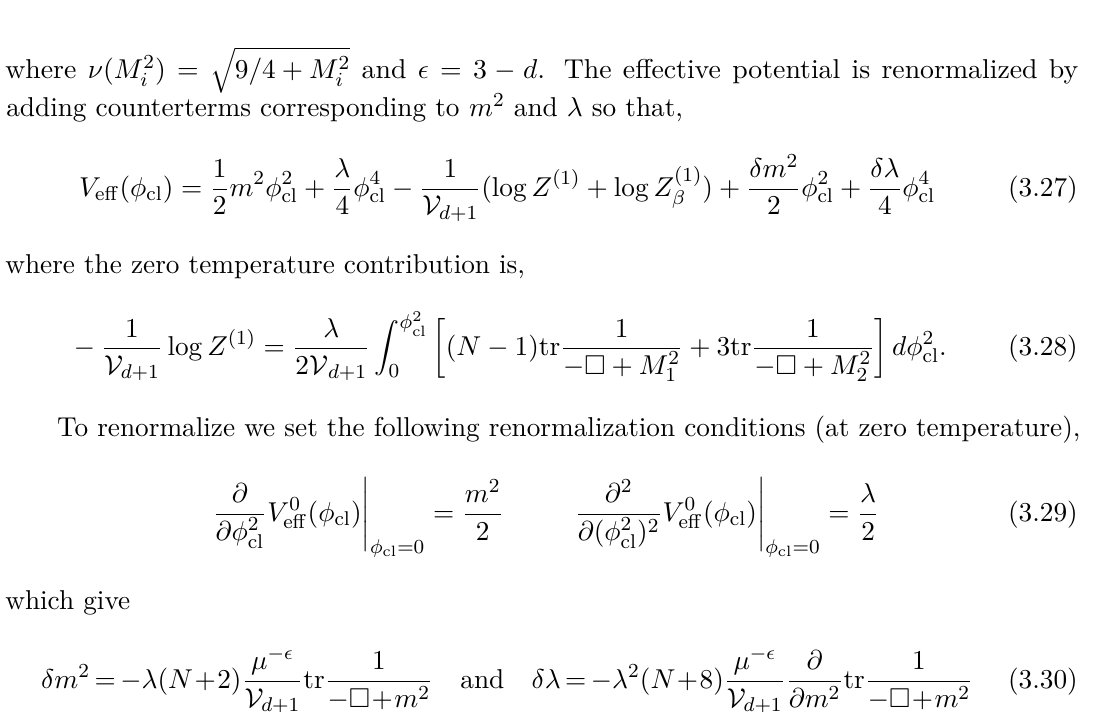
Figure 2. Phases and potentials for λ = 0 . 1 , N = 2 and n = 100 . The potential plots are shown for regions A , B and C